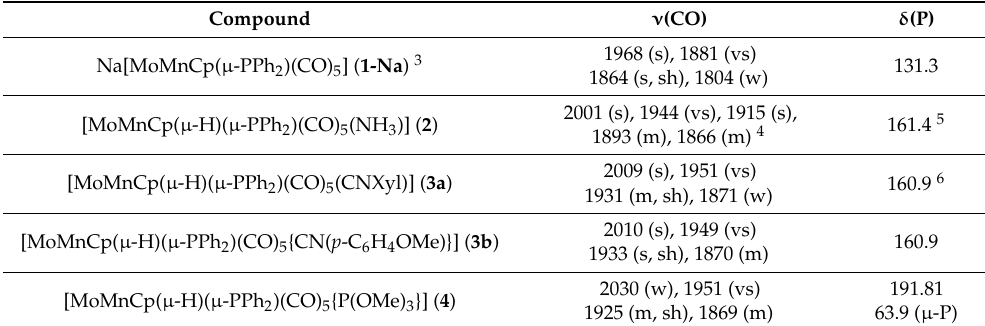
Table 2. Selected IR 1 , and 31 P{ 1 H} Data 2 for New